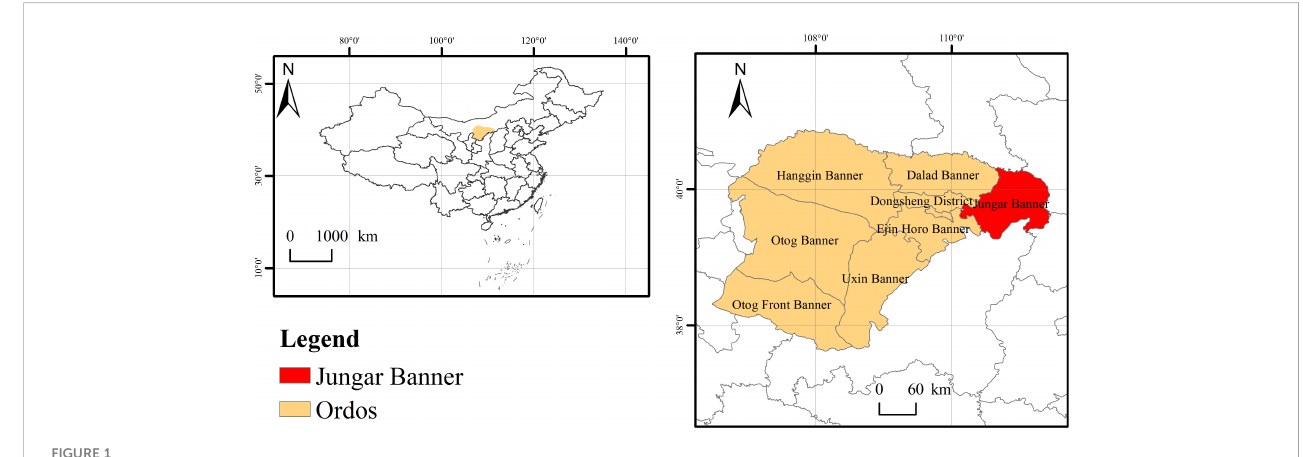
FIGURE 1 Geographical positions of the study